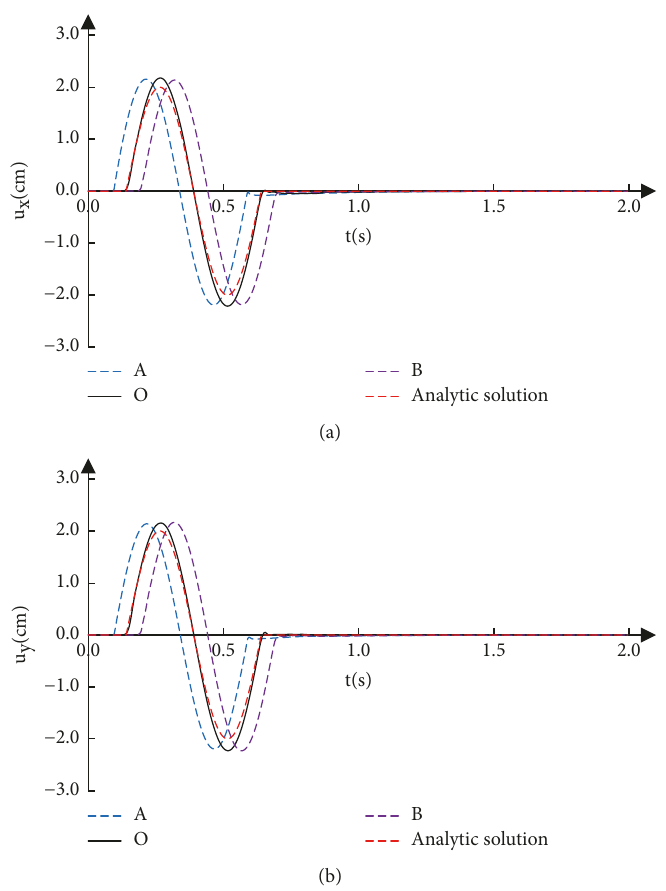
Figure 9: Displacement time history of typical points: (a) horizontal and (b) vertical.